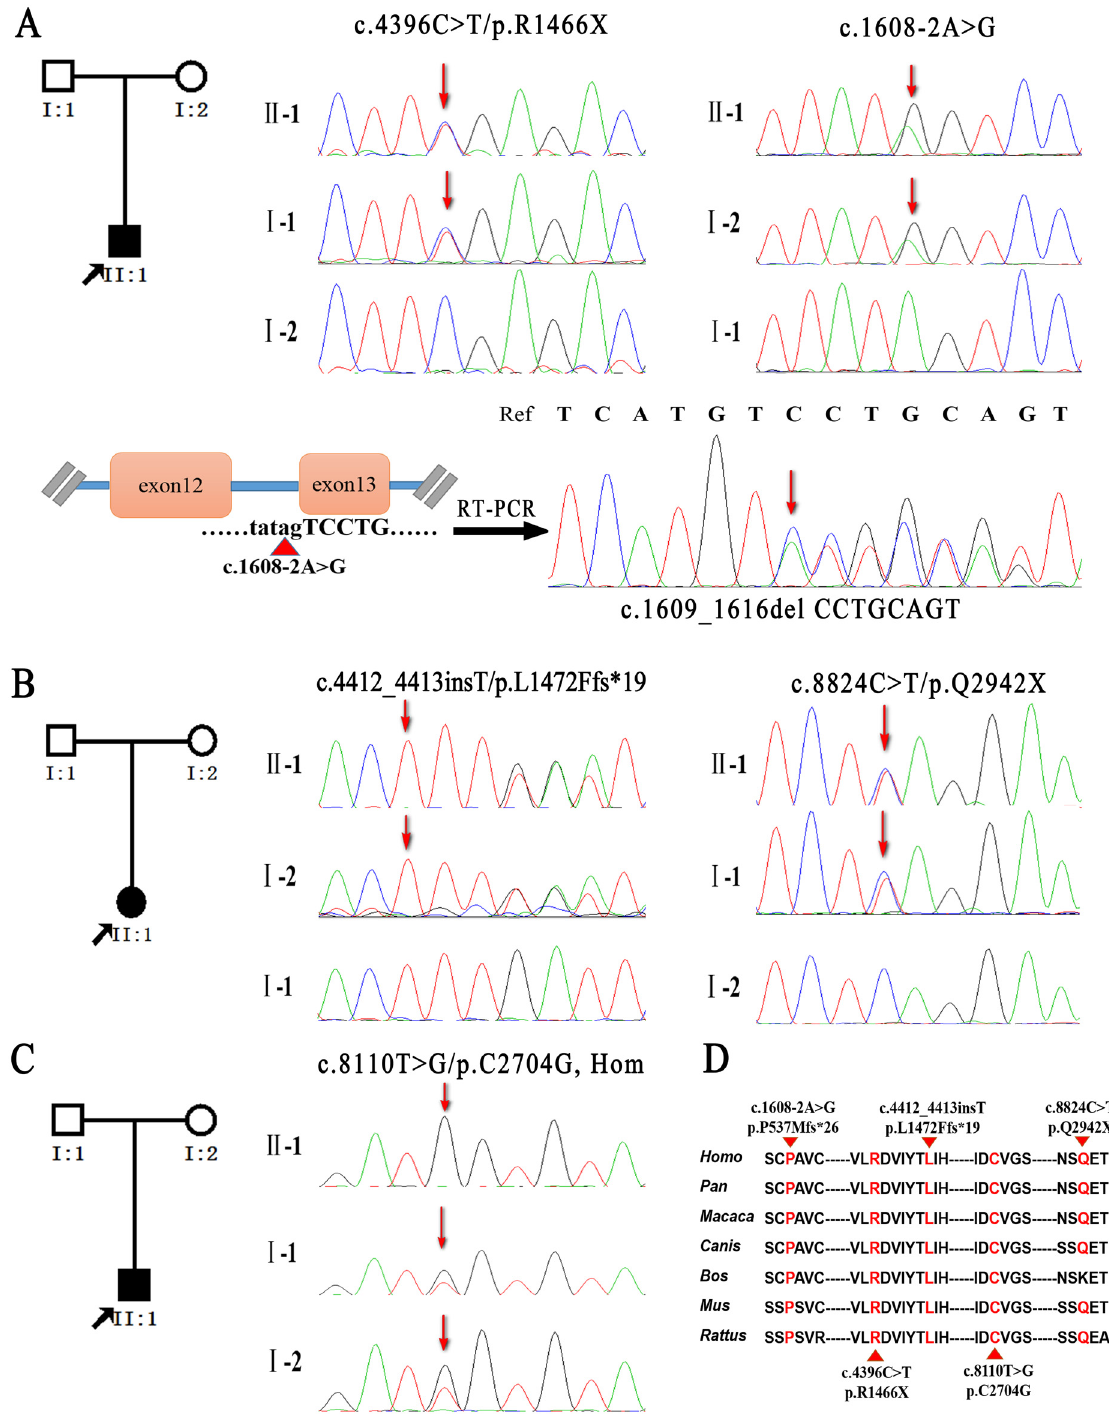
Fig 2. Pedigrees and putative pathogenic mutations. Segregation of mutations in FAT – 1, FAT – 2 and FAT – 3 pedigrees was determined by Sanger sequencing (represented by arrows) (A-C). The splicing mutation of FAT – 1 pedigree was verified via RT-PCR and Sanger sequencing (A). The conserved protein residues were targeted by the mutations identified in the patients